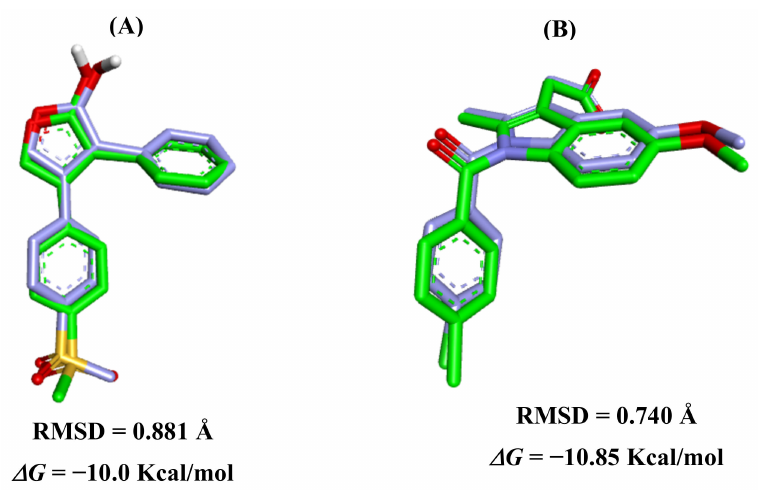
Figure 10. Overlays of crystallographic ligand poses (purple) with docking poses (green): ( A ) RCX for Homo sapiens (PDB ID: 5KIR) and ( B ) IMN for Mus musculus (PDB ID: